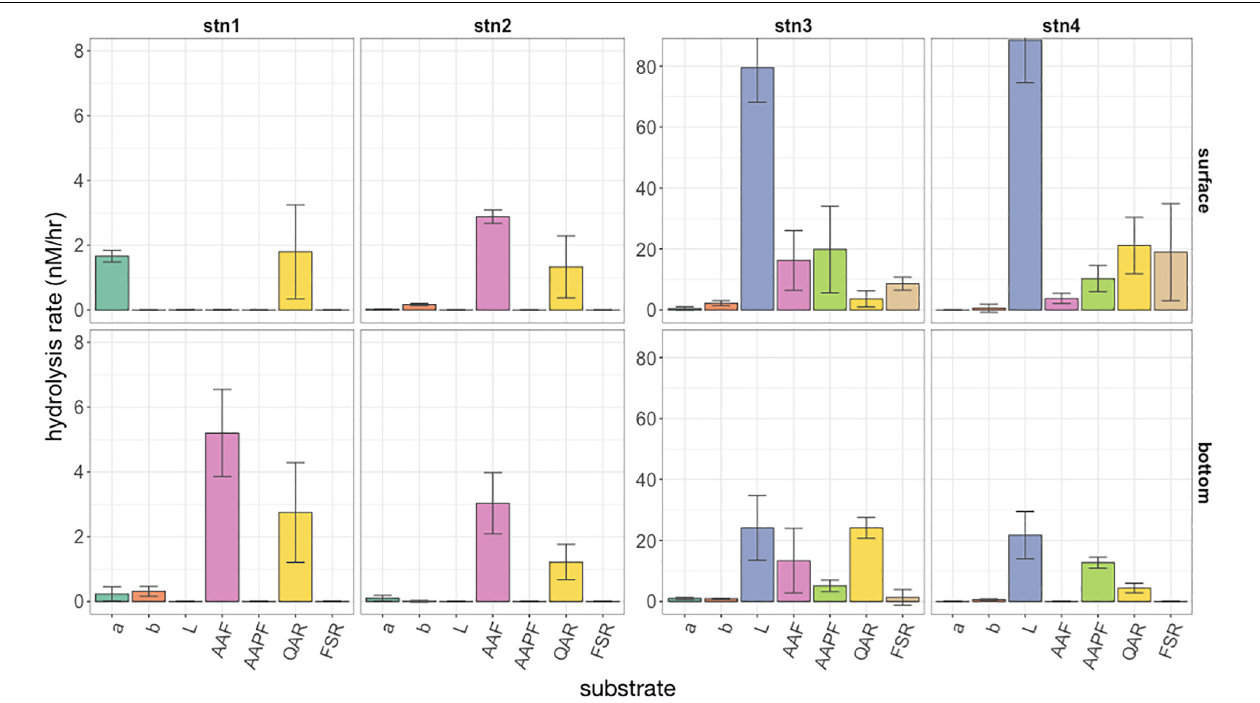
FIGURE 2 | Hydrolysis rate of the seven fluorescently labeled peptide and glucose substrates at each station (left to right) and surface and bottom (top and bottom panels). A-glu, α -glucose; B-glu, β -glucose; Leu, leucine; AAF, alanine-alanine-phenylalanine; AAPF, alanine-alanine-proline-phenylalanine; QAR, glutamine-alanine- arginine; FSR, phenylalanine-serine-arginine. Note the order of magnitude difference in y axes between Stns. 1 and 2 and Stns. 3 and 4. Error bars indicate standard deviation of triplicate incubations around the mean hydrolysis